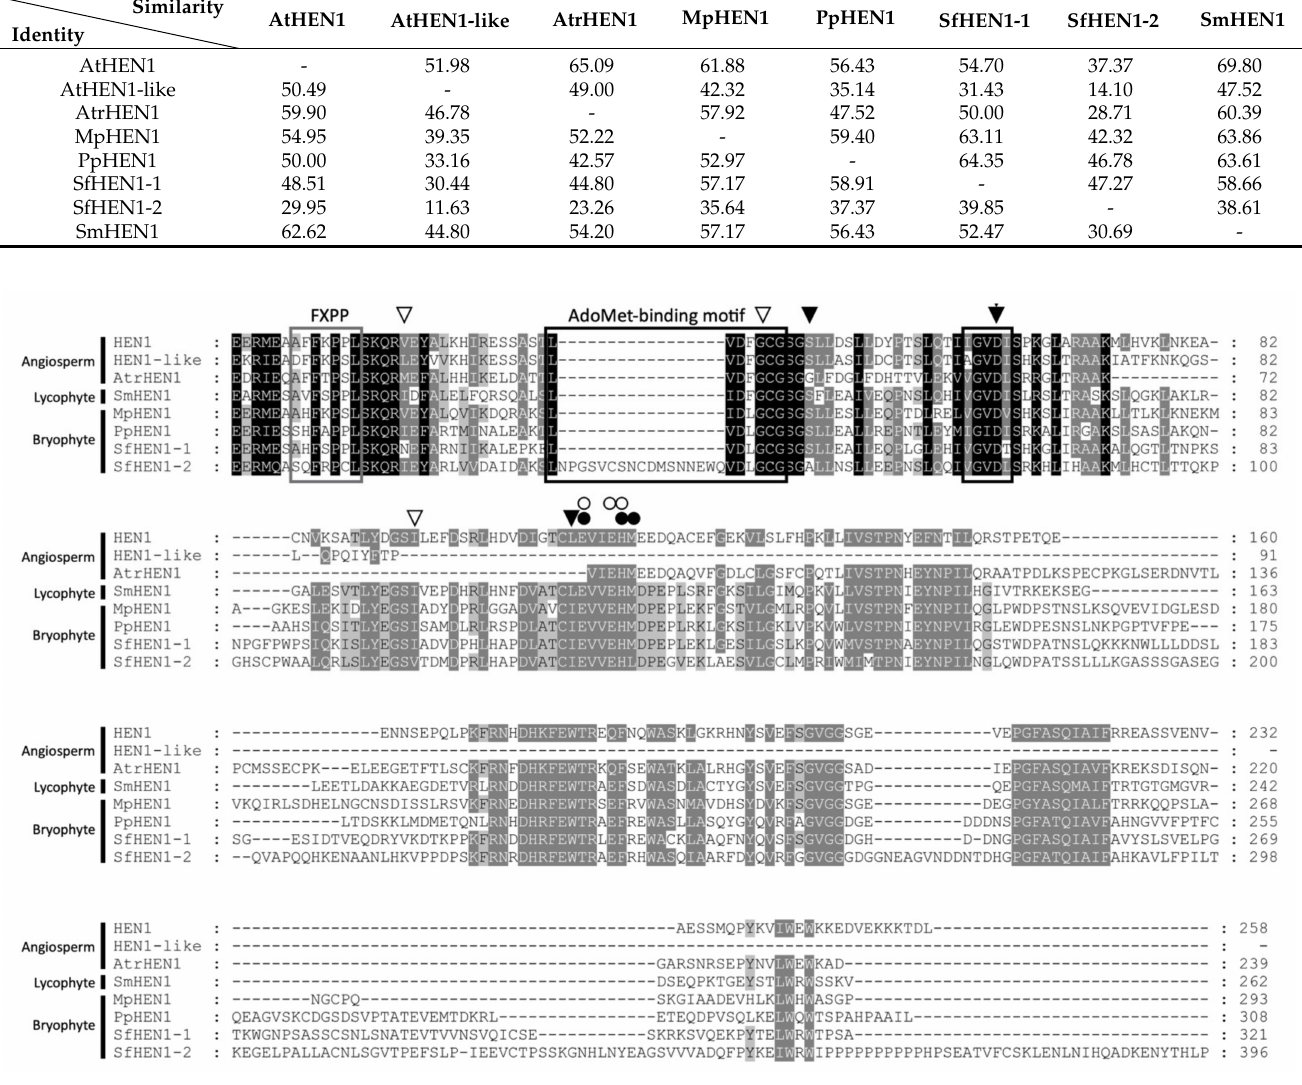
Figure 9. Multiple alignments of the MTase domain among different plant species. The arrowheads and asterisks indicate the SAM-binding residues and metal-binding residues, respectively. The black and grey boxes mark the AdoMet-binding motif and the FXPP motif,